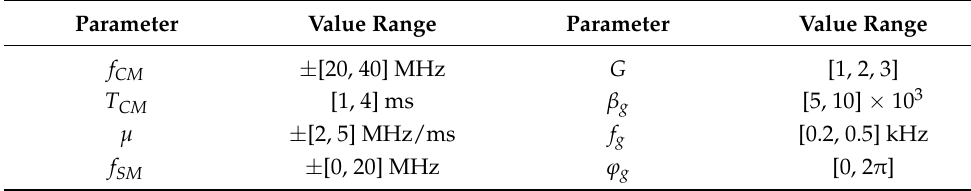
Table 1. Value range of the WBI parameters.